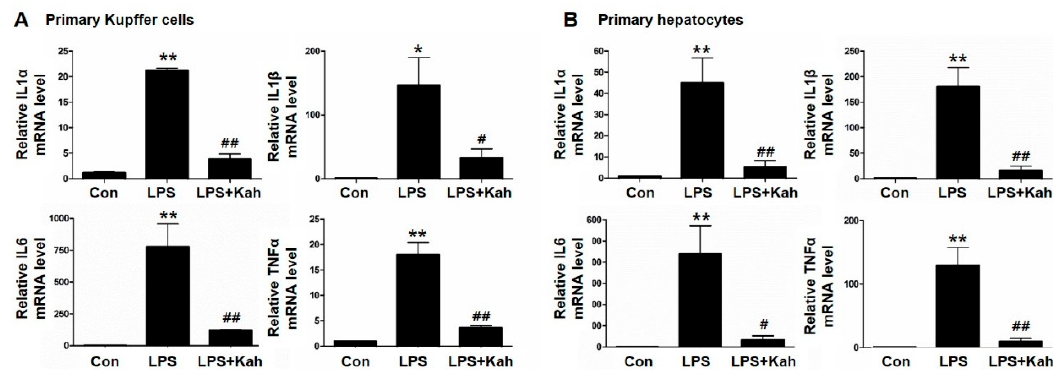
Figure 1. Effect of kahweol on lipopolysaccharide (LPS)-induced inflammatory cytokine mRNA expression in primary Kupffer cells (KC) and primary hepatocyte (HC). ( A , B ) Representative real-time RT-PCR analysis of IL1 α , IL1 β , IL6, and TNF α mRNA expression in primary KC ( A ) and primary HC ( B ). Data in the bar graph are mean ± SEM of three independent measurements. * p < 0.05, ** p < 0.01 compared with control (Con), # p < 0.05, ## p < 0.01 compared with LPS. Kah, Kahweol.